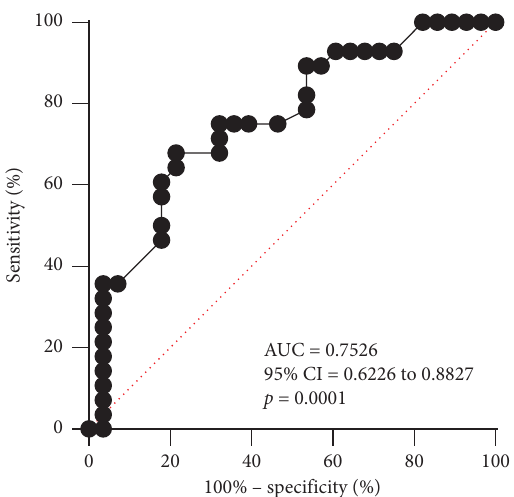
Figure 3: Receiver-operating characteristic curve (ROC) for rel- ative driving pressure change. ROC analysis for the relative change in driving pressure and survival of ECMO therapy; area under the curve (AUC) 0.75265 (chi 2 � 11.27336; p � 0 .